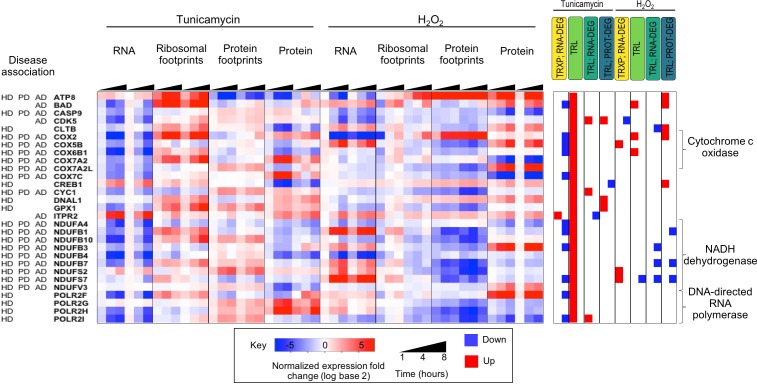
Genes that are translationally up-regulated under ER stress often function in neurodegenerative diseases.The heatmap shows 29 proteins localized to mitochondria and which are significantly translationally induced. They are largely components of cytochrome c oxidase, NADH dehydrogenase, and DNA-directed RNA polymerase and are involved in a variety of neurodegenerative diseases. HD - Huntington’s disease; PD - Parkinson’s disease; AD - Alzheimer’s. disease.